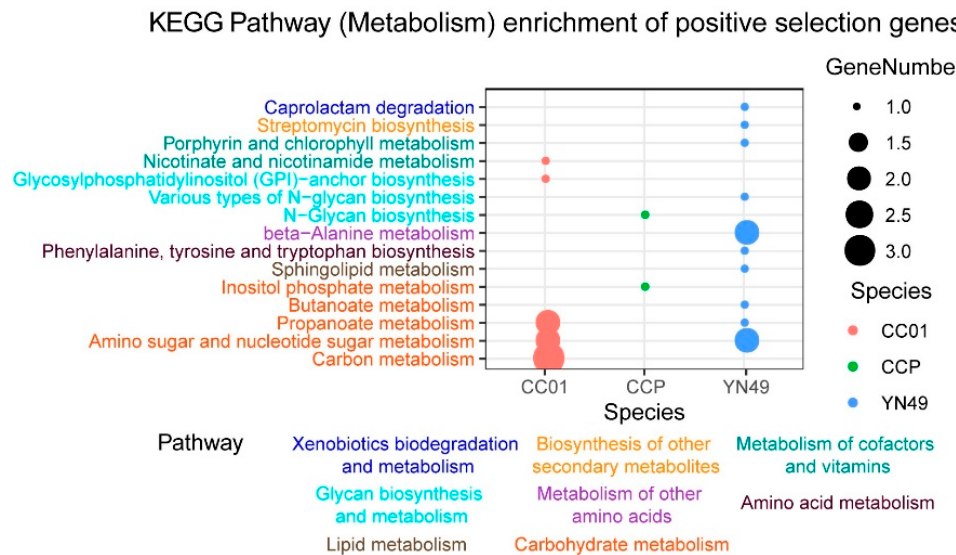
Figure 4. KEGG distribution (metabolic pathways) of positively selected genes in C. cassiicola YN49, CC01 and CCP strains.